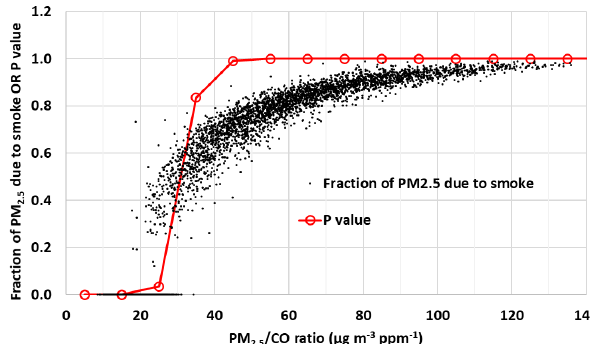
Figure 5. Fraction of PM 2 . 5 due to smoke vs. the PM 2 . 5 / CO ratio (µgm − 3 ppm − 1 ) as calculated from the Monte Carlo simulations. We note that the Monte Carlo simulations give a probabilistic re- lationship. So, for example, at a PM 2 . 5 / CO ratio of between 30 and 40µgm − 3 ppm − 1 , 83% of the points have more than half of the PM 2 . 5 due to smoke. The open red circles show the probabil- ity that more than 50% of the PM 2 . 5 is due to smoke within each PM 2 . 5 / CO